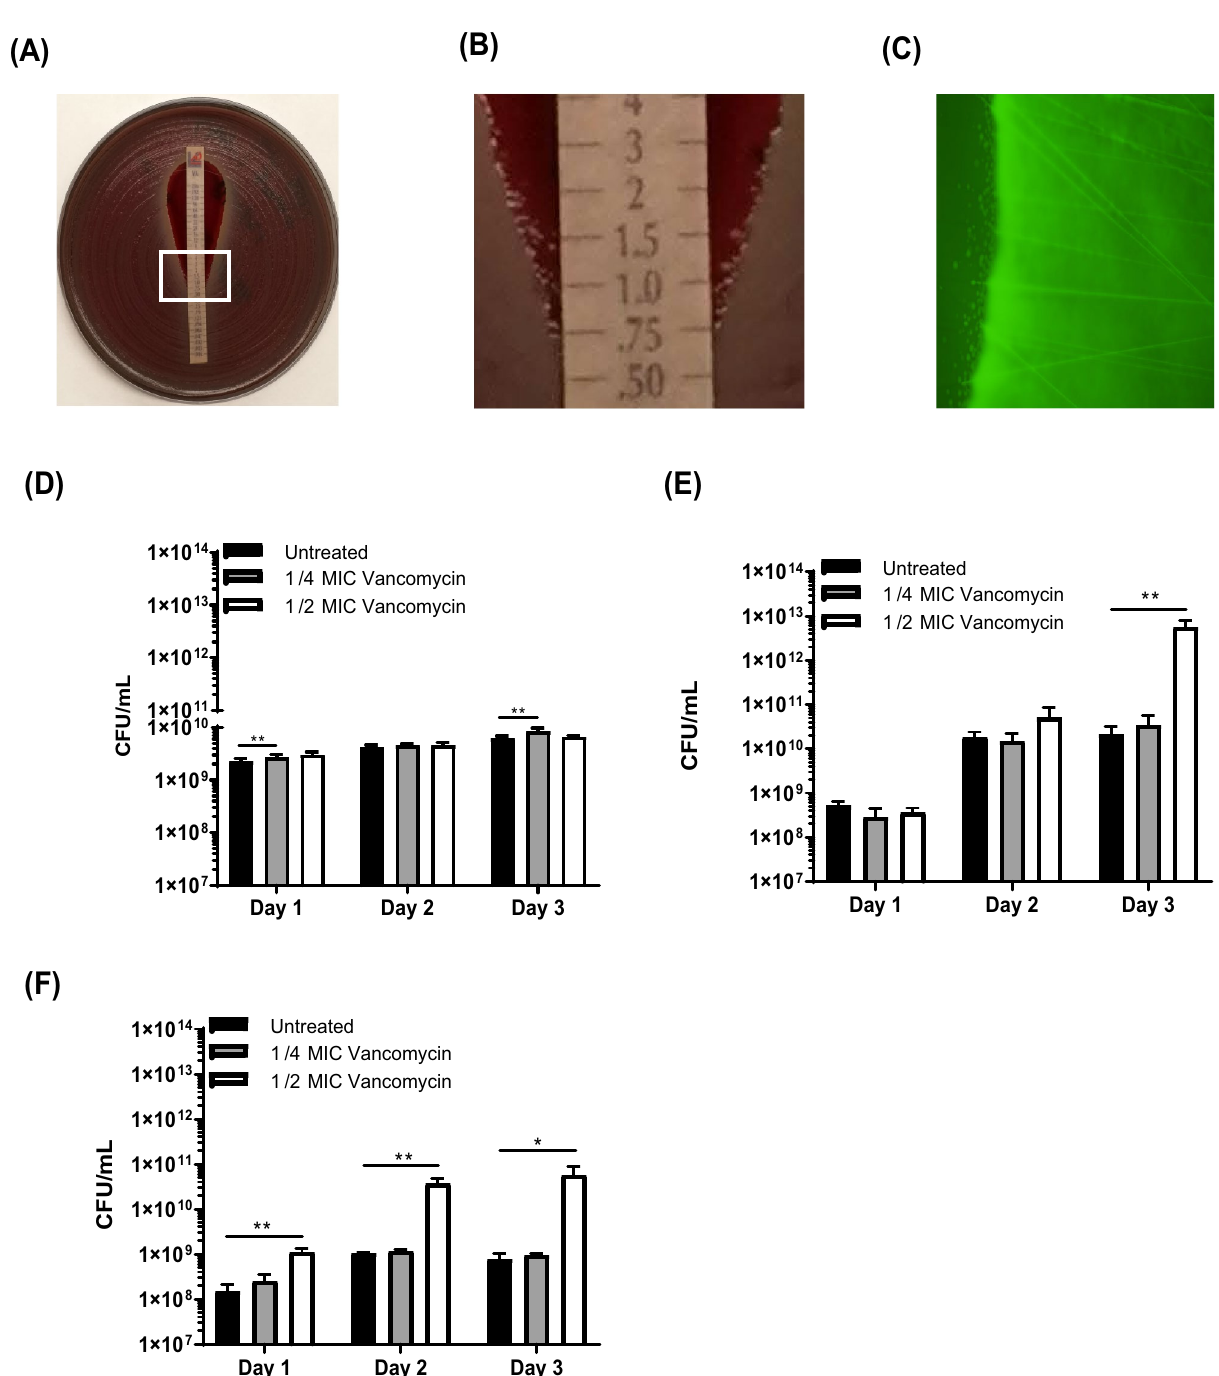
Figure 1. Sub-MIC vancomycin promotes S. aureus planktonic growth ( A ) MRSA JE2 vancomycin E-test strip MIC assay. White box indicates zoomed in area for ( B ) a greater bacteria accumulation occurs near the edge of E-test strip inhibitory area ( C ) MSSA Newman strain containing an EGFP fluorescent reporter demonstrating a brighter green fluorescent signal near the edge of the vancomycin inhibitory are a indicating more bacterial growth. Sub-MIC vancomycin promotes increased planktonic growth in ( D ) MRSA JE2 ( E ) MSSA Newman and ( F ) SH1000. N = 4 per treatment group. Error bars represent standard deviation. *p < 0.05, **p <